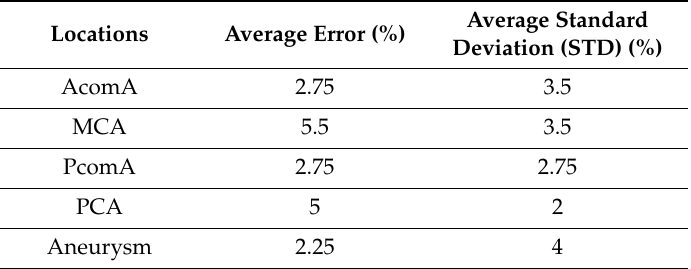
Table 1. The measured error and standard deviation (STD) of arteries manufactured by the proposed fabrication process in this